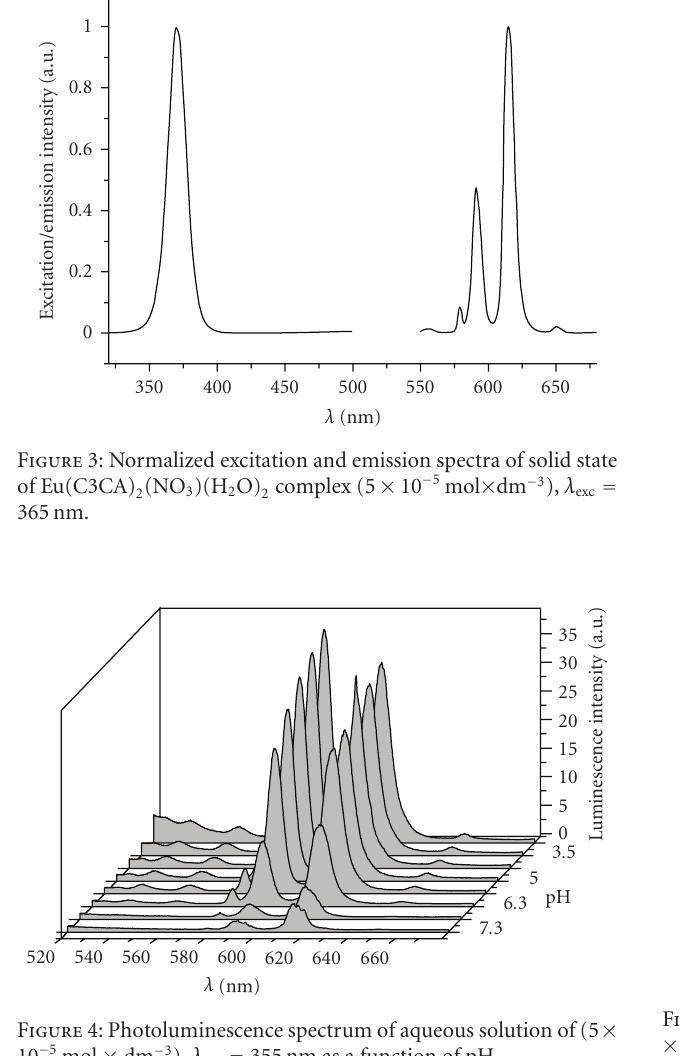
process, in the same geometrical conditions. The excitation